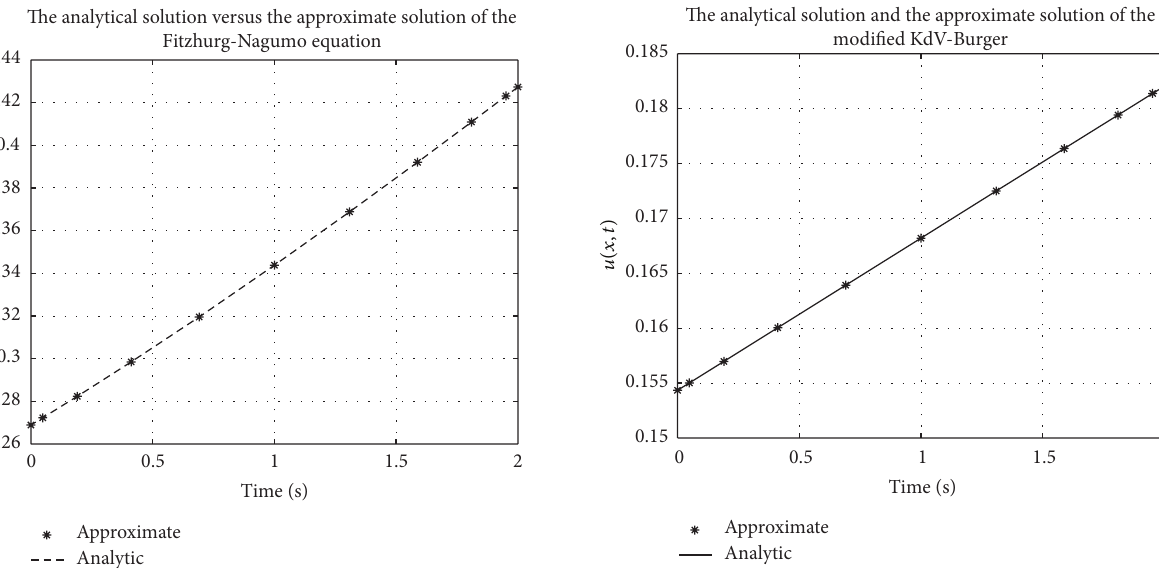
Figure 3: Fitzhugh-Nagumo equation analytical solution graph.